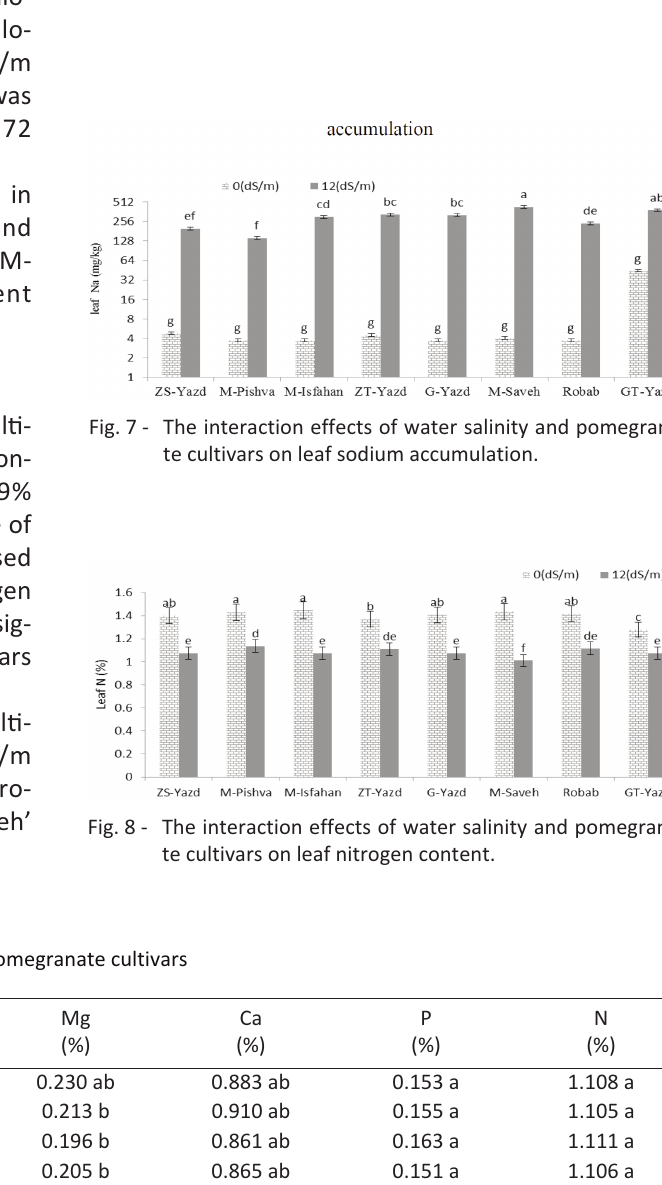
Fig. 6 ­ The interaction effects of water salinity and pomegrana­ te cultivars on leaf chloride accumulation.